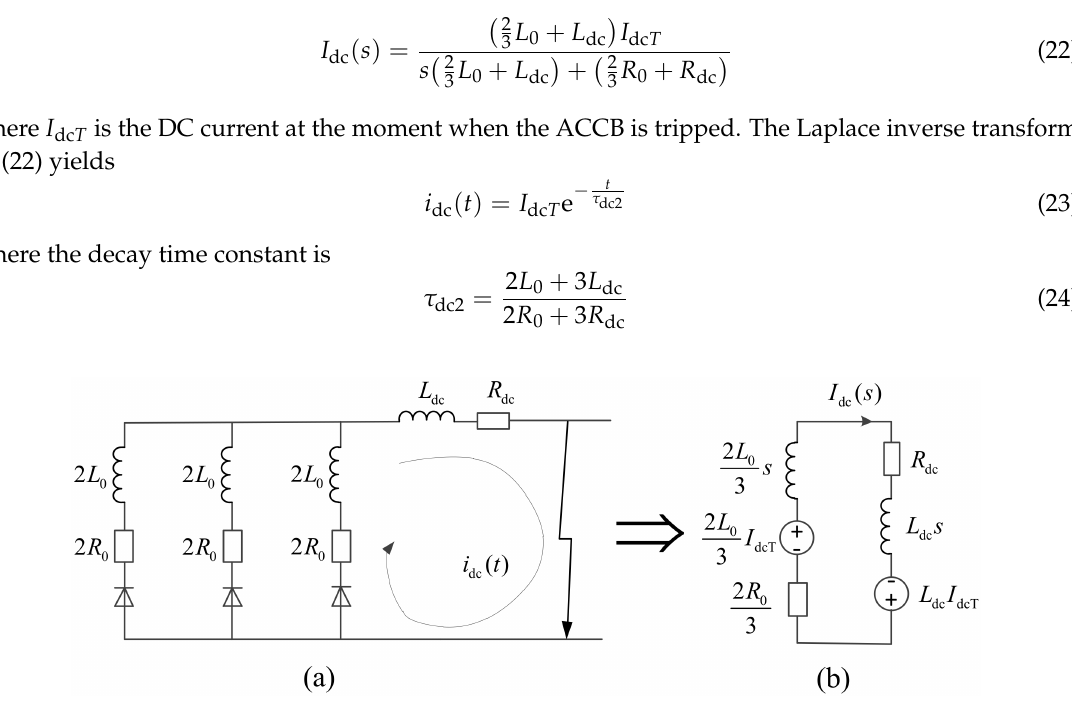
Figure 5. Circuit after the ACB is tripped. ( a ) Equivalent circuit; ( b ) Operation